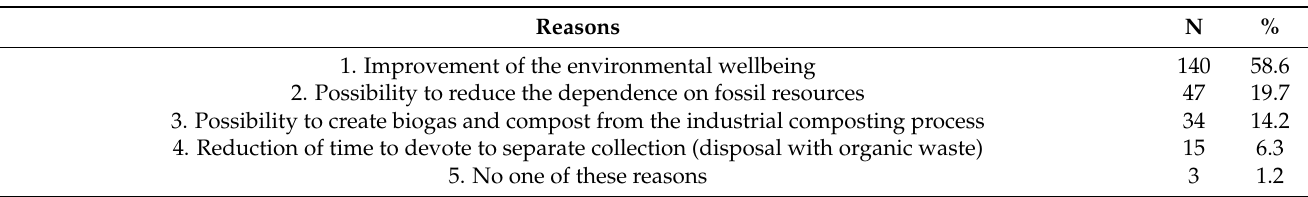
Table A4. Reasons for the intention to purchase biodegradable packaging for milk ( n =